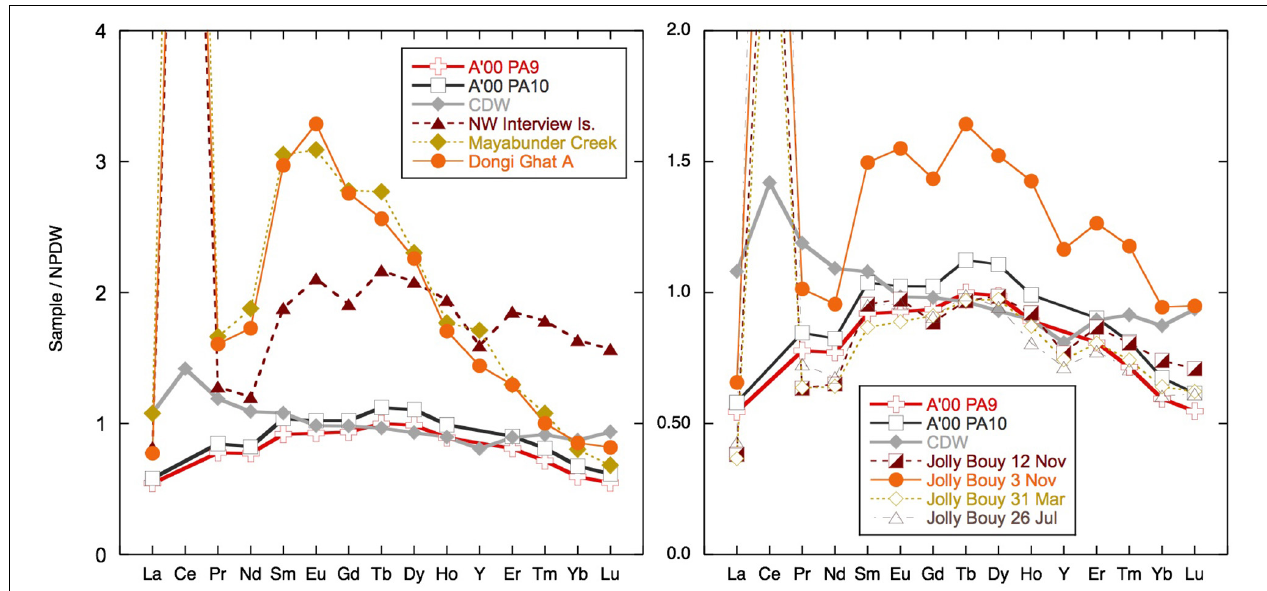
FIGURE 10 | Selected samples normalized to North Pacific Deep water (NPDW) after Alibo and Nozaki (1999). The two surface samples measured by Amakawa et al. (2000) in the Bay of Bengal (BoB) and Andaman Sea (AnS) and Circumpolar Deep Water (CDW) from the Southern Ocean taken from Hathorne et al. (2015) are plotted for